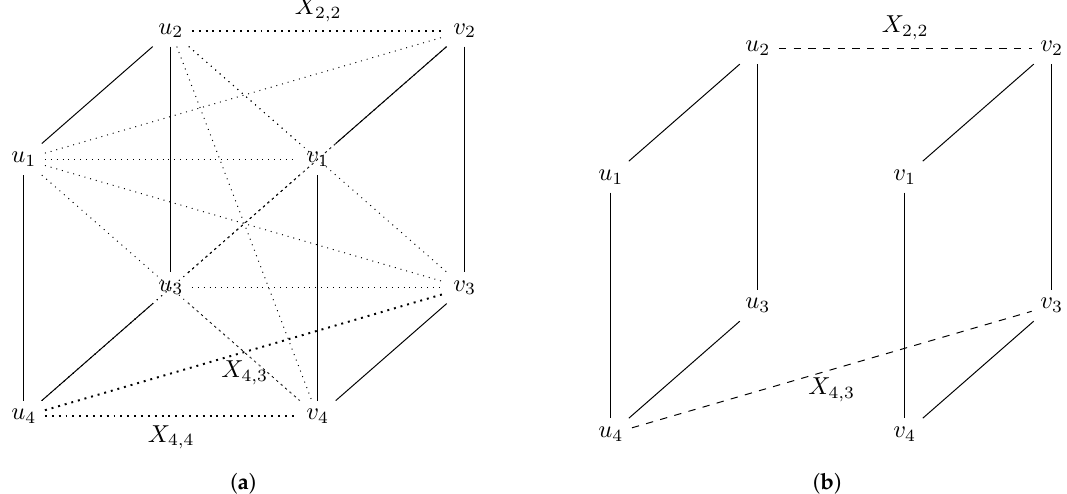
Figure 2. Process of generating the polynomial set associated to graph isomorphism. ( a ) An isomorphism between G and H can be seen as a perfect matching in the graph K U , V , preserving adjacencies between G and H . ( b ) The edges u 2 v 2 and u 3 v 4 cannot belong simultaneously to M because u 2 u 3 D , but v 2 v 4 / E . The polynomial X 2,2 X 3,4 is added to the ideal I ∈ ∈